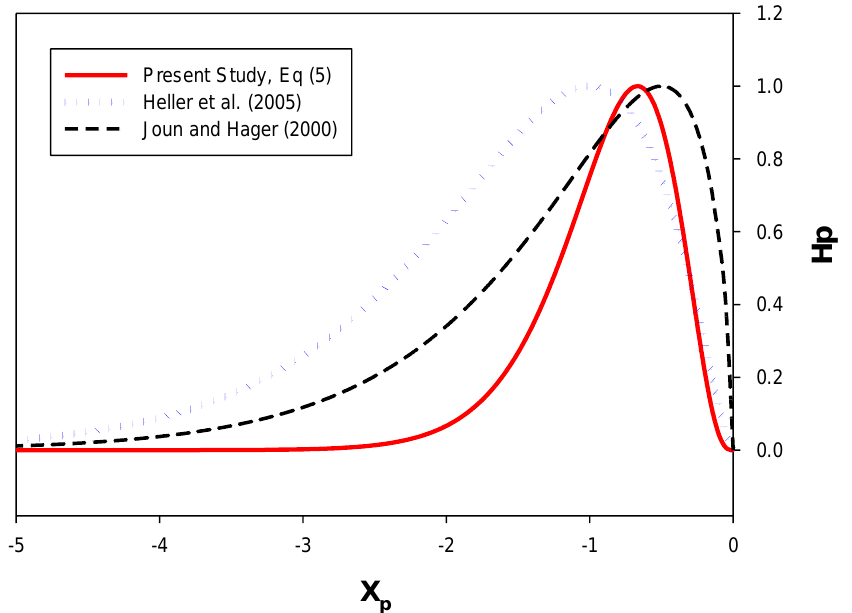
Figure 12. Comparison of the results the present study and studies of Heller et al. (2005) and Juon & Hager